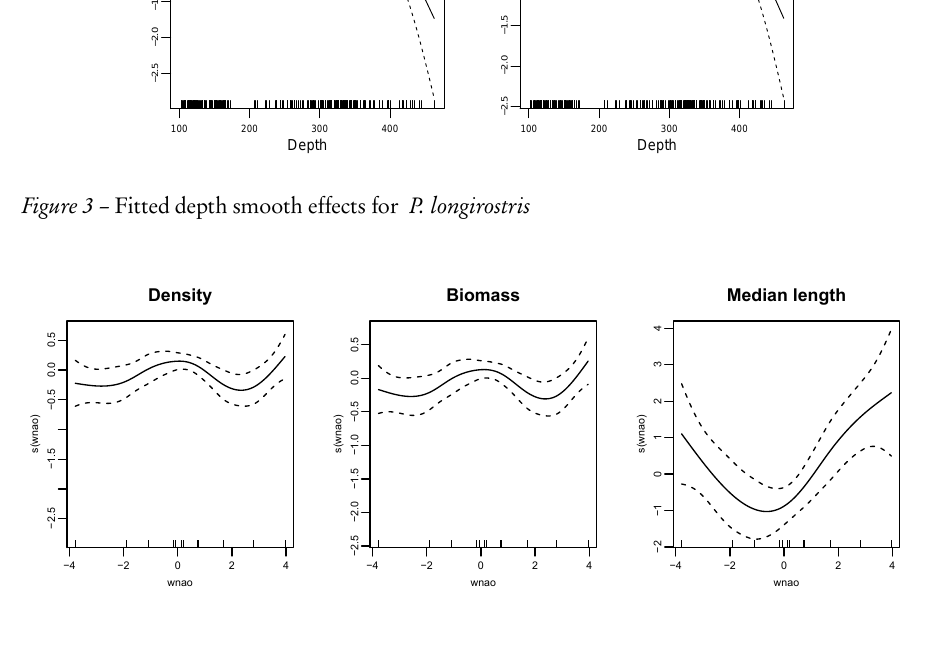
Figure 4 – Fitted WNAO smooth effects for P.